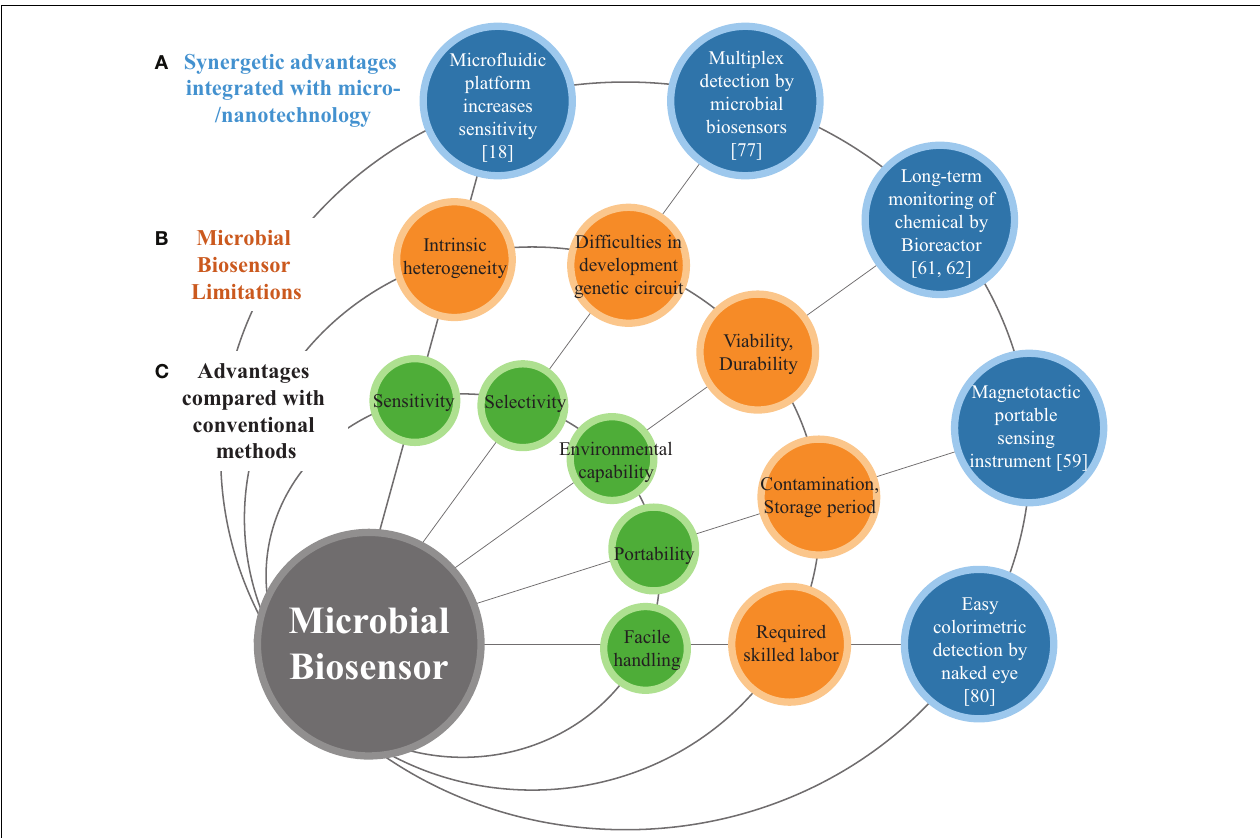
FIGURE 1 | Schematic diagram represents (A) micro/nanotechnolgies enhancing the performance of microbial biosensors, (B) limitations of conventional microbial biosensors, and (C) general features of biosensors